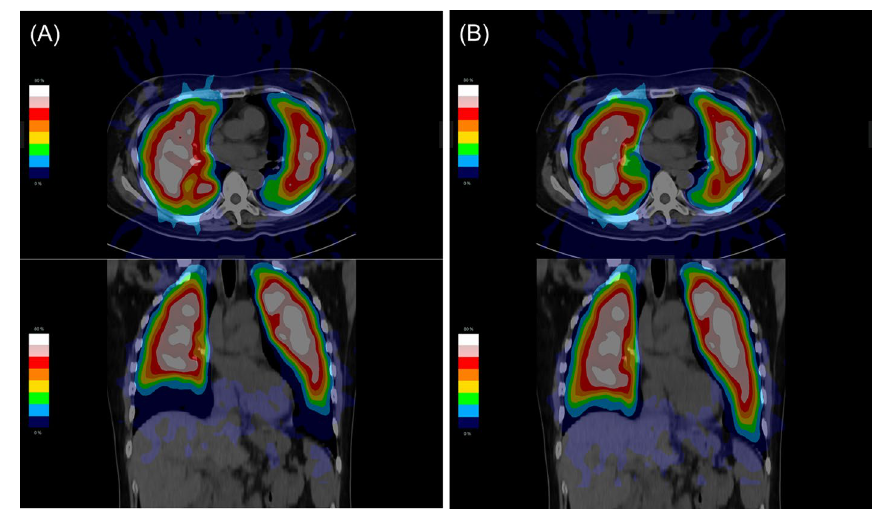
Fig. 4 The fusion images between SPECT and CT before and after using the breathing synchronization software. A 50-year-old woman underwent lung perfusion SPECT and CT due to suspected PE; she had no abnormal morphological findings on the CT image and the lung perfusion SPECT image revealed normal lung perfusion. The lung volume calculated using CT was 4332 ml. A Before using the breathing synchronization software, the lung volume calculated using the original lung perfusion SPECT was 3351 ml; B after using the breathing synchronization software, the lung volume calculated using lung perfusion SPECT with the breathing synchronization software was 3974 ml; the volume of lungs calculated from SPECT with the breathing synchronization software was increased, and the conformity between lung perfusion SPECT and lung CT was improved. Abbreviations: CT computed tomography; PE pulmonary embolism; and = = SPECT single-photon emission computed =